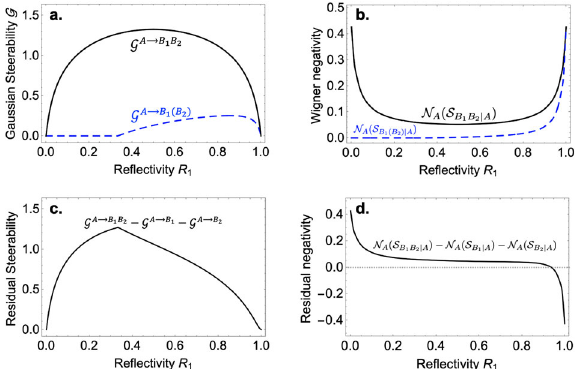
Fig. 6 A violation of CKW-type monogamy constraint of Wigner negativity. In the same scheme discussed in Fig. 2a, the fi rst beamsplitter R 1 is adjustable and the second beamsplitter is fi xed at R 2 : (1 − R 2 ) = 50: 50. The input squeezing levels r = 1 ( − 8.7dB quadrature noise). a The initial Gaussian steerabilities varying with R 1 . b The corresponding transferred Wigner negativities in the steering mode A by applying single-photon subtraction on the individual mode B 1 ( B 2 ), or their joint ( B 1 B 2 ), respectively. c The residual tripartite Gaussian steering G A ! B 1 B 2 (cid:3) G A ! B 1 (cid:3) G A ! B 2 (cid:5) 0 which is stemming from the reverse CKW-type monogamy. d The residual tripartite Wigner negativity remotely created in mode A